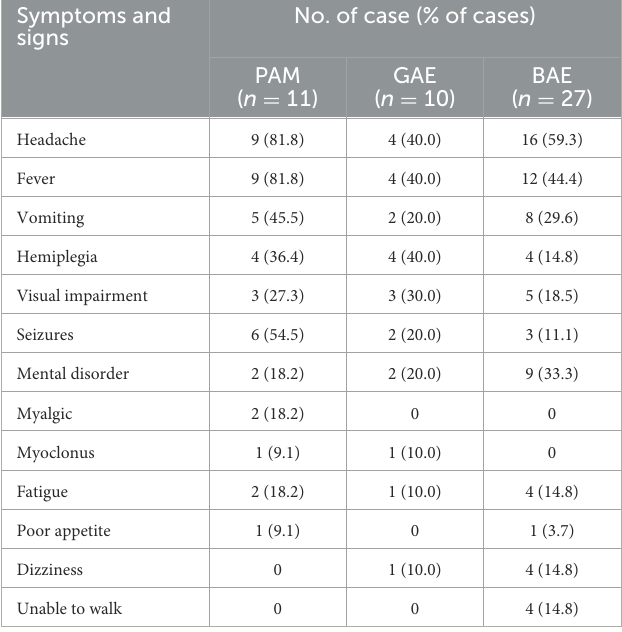
TABLE 2 The initial or main clinical symptoms and signs of 48 clinical cases. Symptoms and